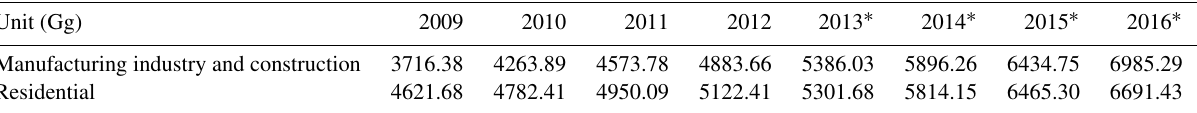
Table 12. Annual CO 2 emissions from electricity consumption in the manufacturing industry and construction sector and residential sector (emission for years marked with ∗ were calculated from electricity consumption provided by JICA (2017a), while other emissions for other years were calculated proportionally with annual gross output of industry at current prices by industry activity and annual population in HCMC).